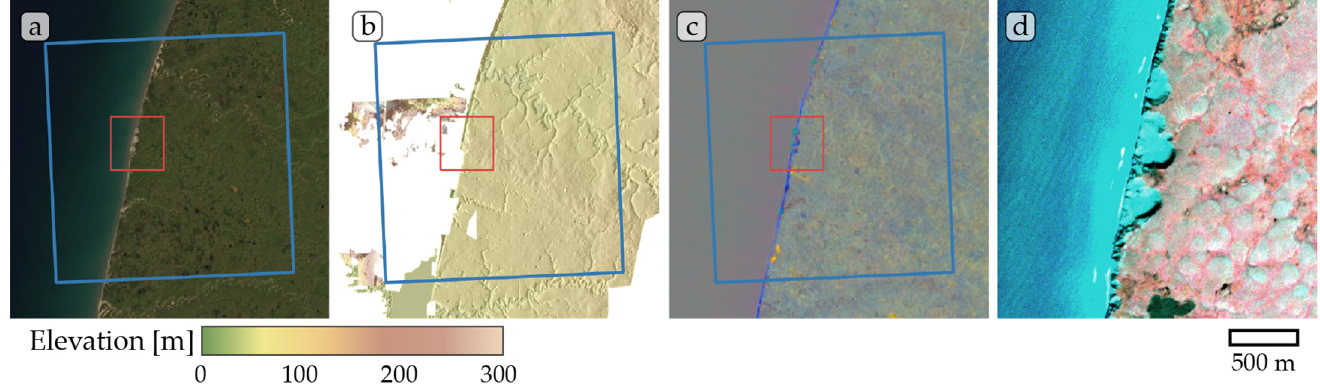
Figure A5. Study site Horton 02. ( a ) ESRI satellite layer, ( b ) ArcticDEM superimposed with hillshade, ( c ) Tasseled Cap trend visualization, ( d ) PlanetScope satellite image (NIR-R-G) acquired on 27 July 2019. Blue box, 10 × 10 km study site. Red box detailed view of ( d ).